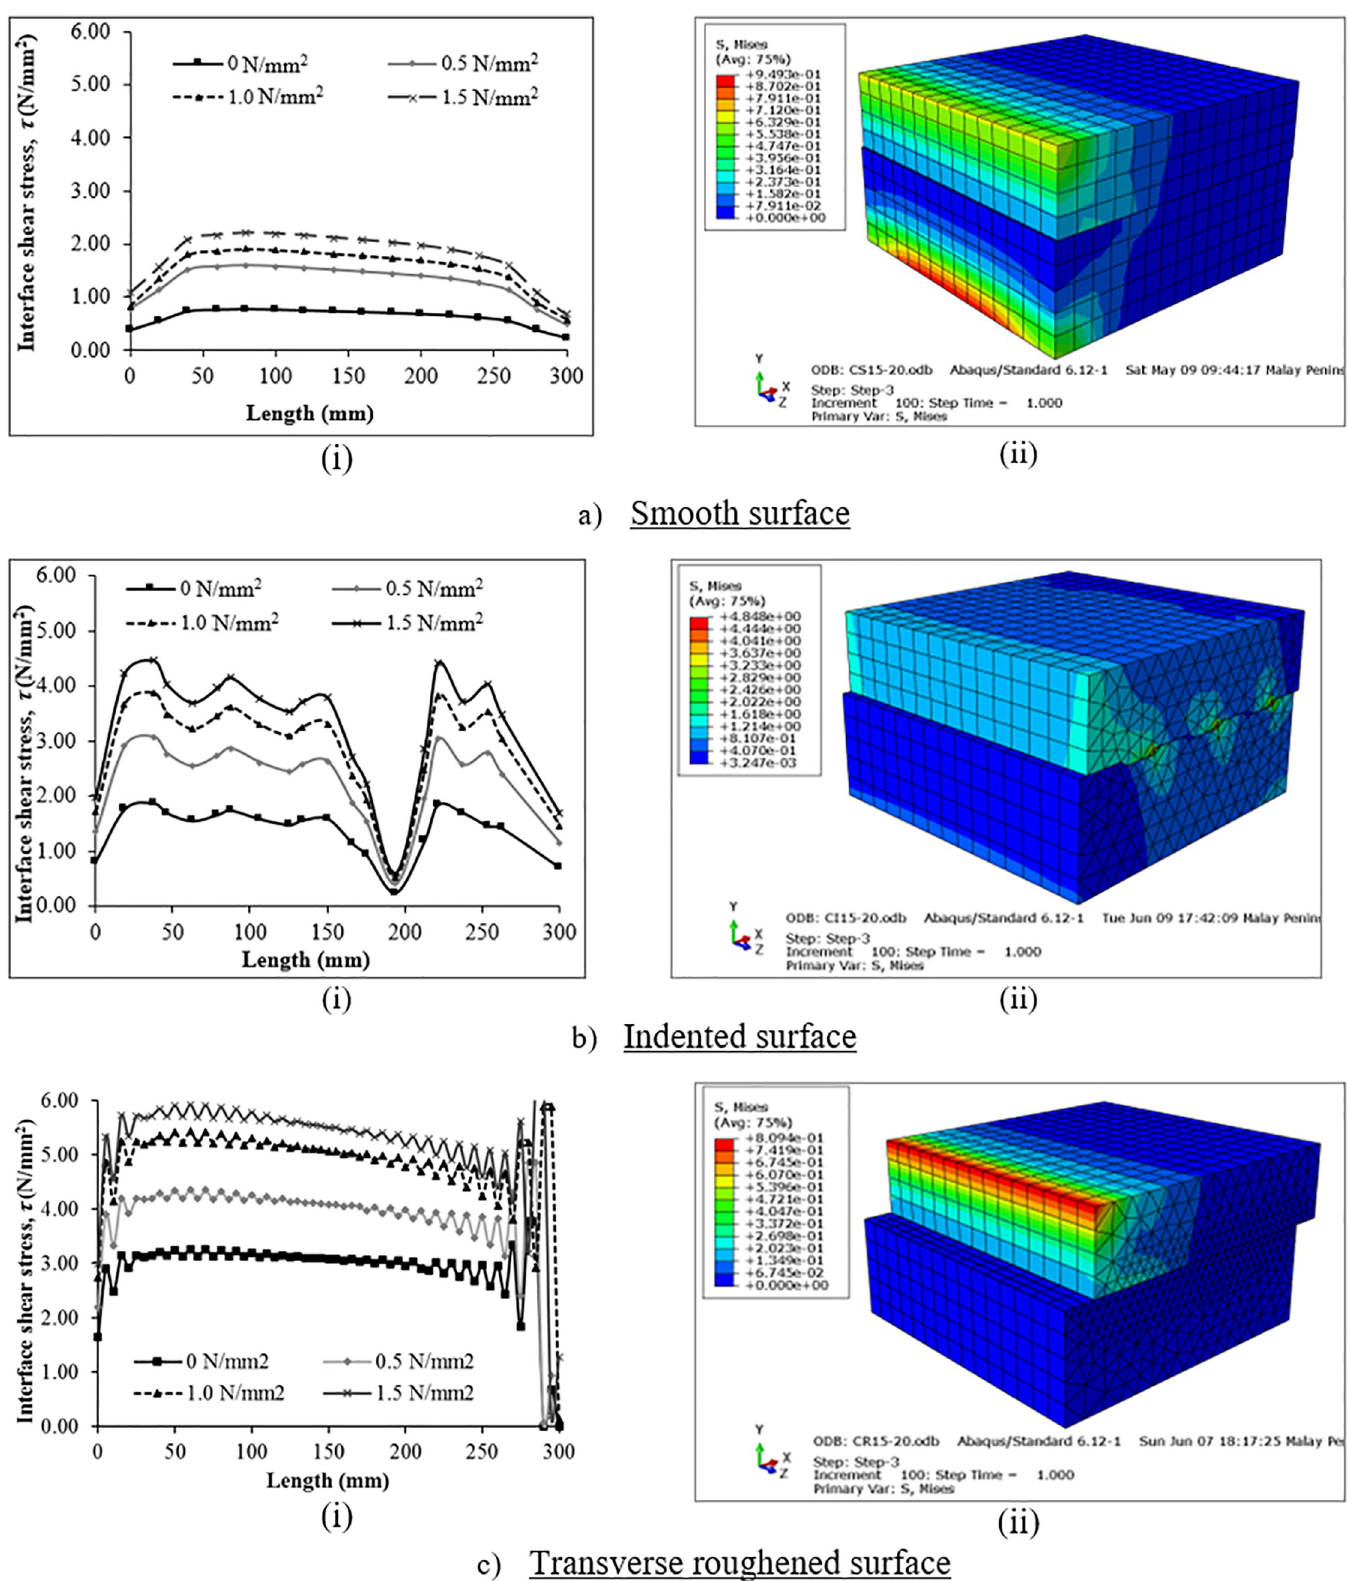
Fig 11. Interface shear stress (i) evolution relationship and (ii) distribution at peak shear load. https://doi.org/10.1371/journal.pone.0252050.g011 PLOS ONE | https://doi.org/10.1371/journal.pone.0252050 May 20,